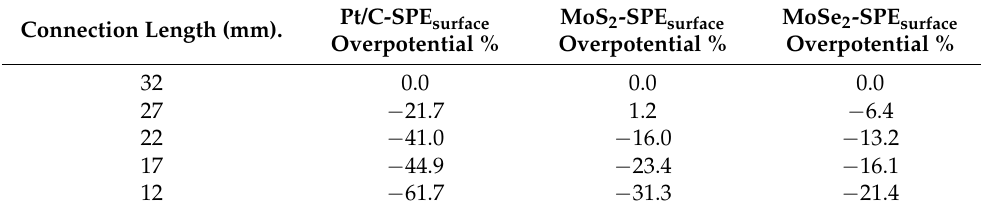
Table 1. Comparison of the relative overpotential values, expressed as percentages, for the HER catalysts Pt/C, MoS 2 and MoSe 2 when surface-modified onto SPEs of different connection lengths. Measured in 0.5 M H 2 SO 4 with potentials reported vs. the reversible hydrogen electrode (RHE). Pt/C-SPE surface MoS 2 -SPE surface MoSe 2 -SPE surface Connection Length (mm). Overpotential % Overpotential % Overpotential % 32 0.0 0.0 0.0 27 − 21.7 1.2 − 6.4 22 − 41.0 − 16.0 − 13.2 17 − 44.9 − 23.4 − 16.1 12 − 61.7 − 31.3 −